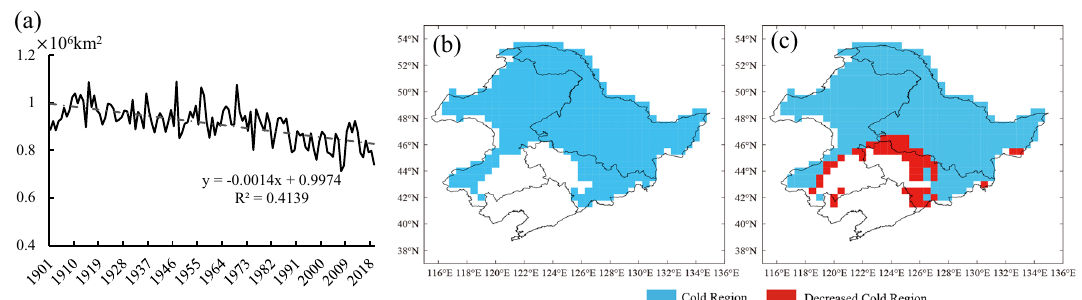
y = -0.0014x + 0.9974 R² = 0.4139